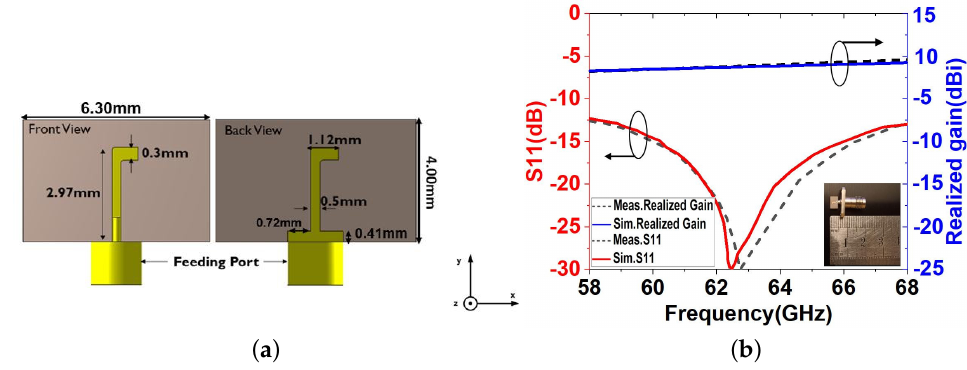
Figure 4. The feeding PDA structure. ( a ) dimensions in front view and back view; ( b ) simulated and measured S 11 and realised